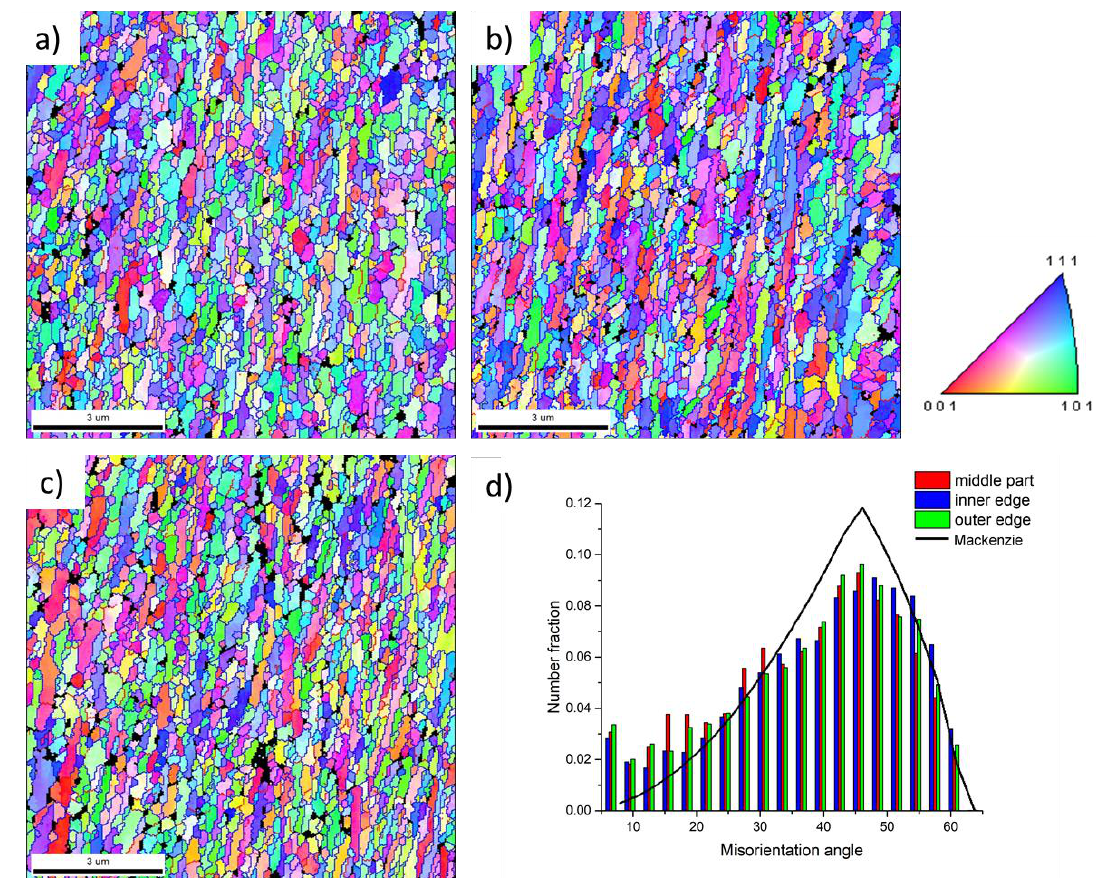
Figure 4. The microstructure of the final CSET-processed tube on the ND plane at different distances from the mandrel: ( a ) OIM at the inner tube surface, ( b ) in the middle of the wall, ( c ) at the outer tube surface, and ( d ) the distribution of misorientation angles (in